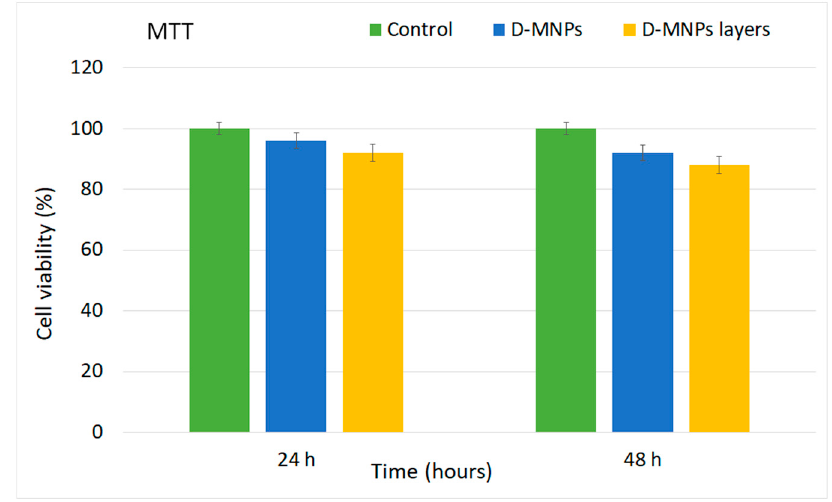
Figure 9. HeLa cell viability after incubation with the D-MNP suspension and the D-MNP layers at different incubation times.